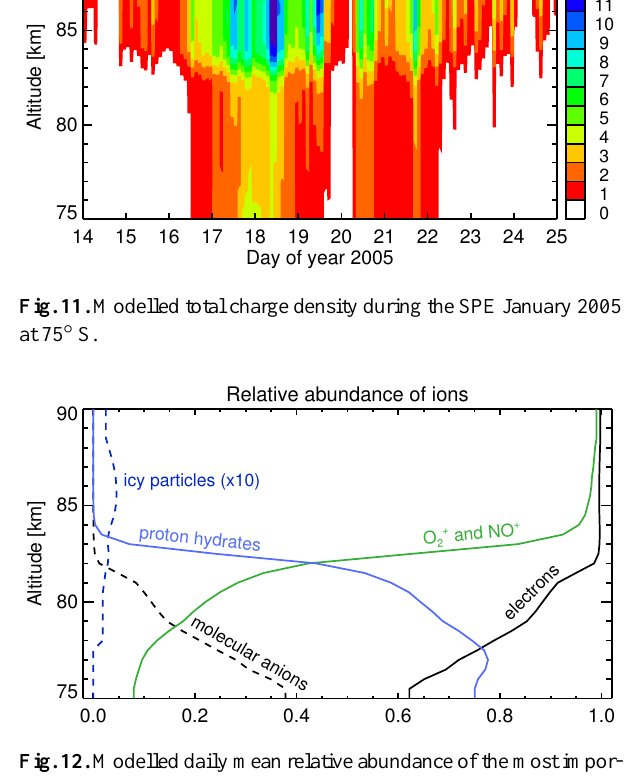
Fig. 14. Daily mean difference between a model run with ion chem- istry and a model run without ion chemistry at 75 ◦ S. The negative values correspond to less icy particles due to ion chemical water depletion. The solid contour lines show the difference of the total number of icy particles per cm 3 , and the color contours depict the difference in the ice mass in units of 10 − 15 gcm − 3